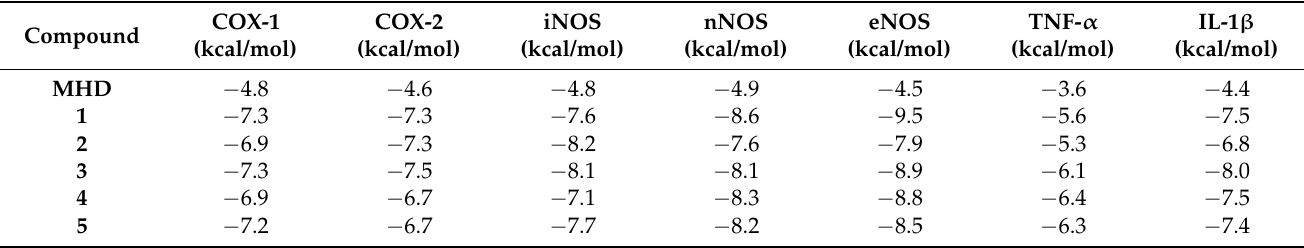
Table 3. Docking scores of 1-methylhydantoin cinnamic imides to three target